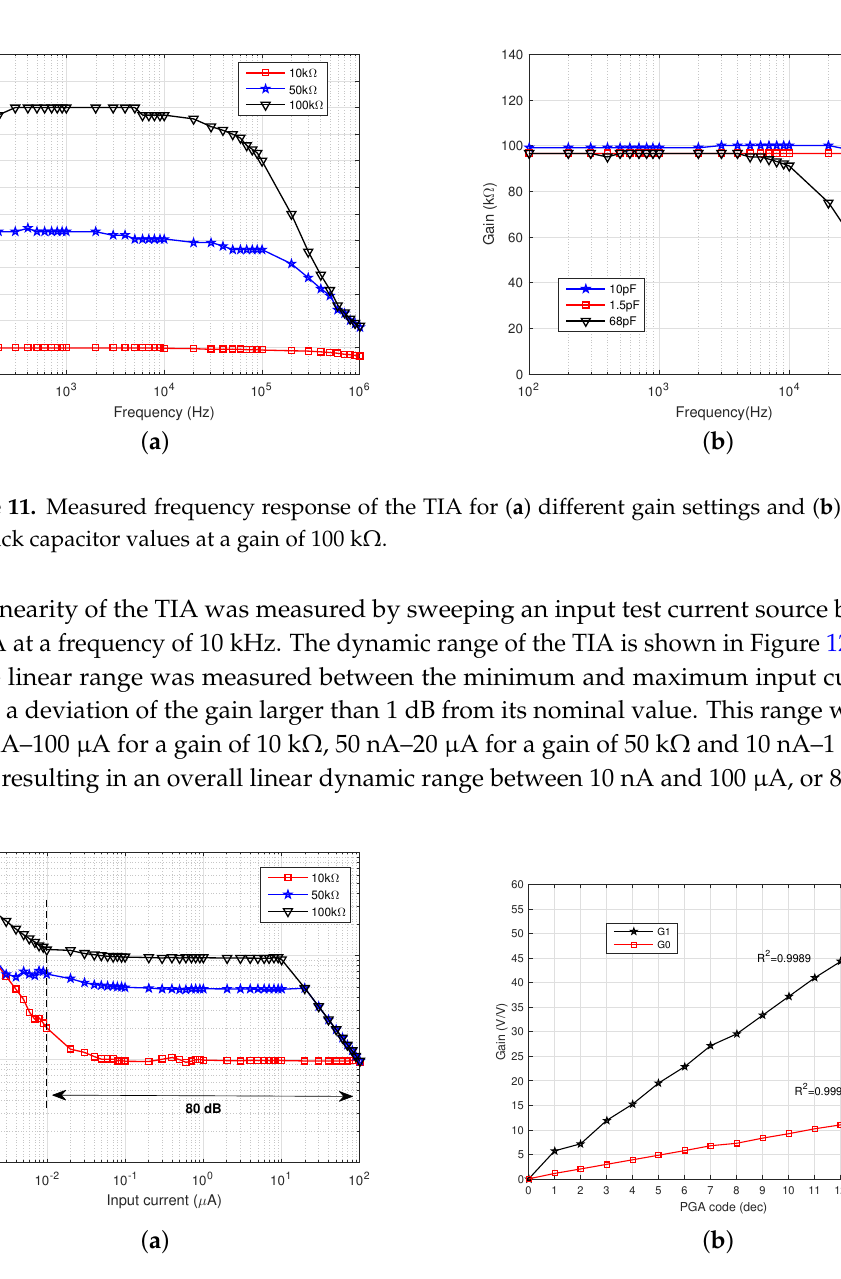
Figure 12. Measured range and linearity of the ( a ) TIA and ( b )